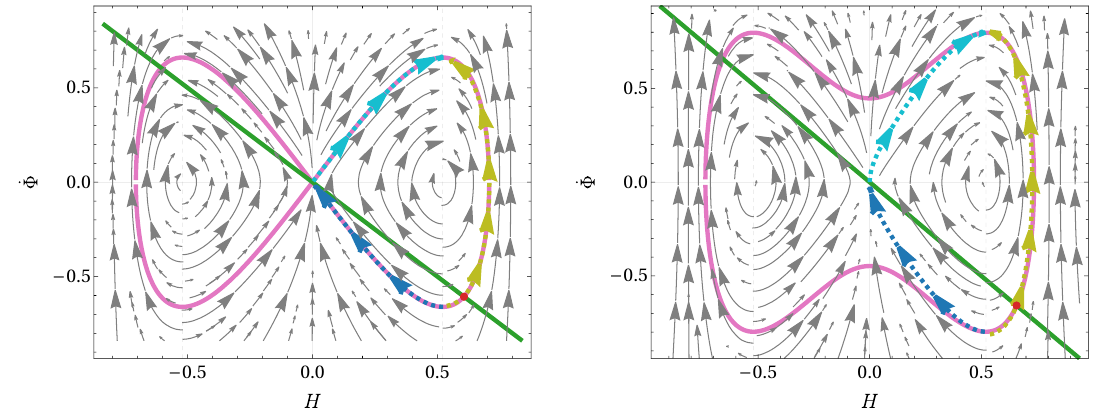
Figure 1 . Phase space diagram for the DBI ansatz (4.10) obtained from eqs. (4.11)–(4.12) for matter with w = λ = 0 . Units with α 0 = 1 are used, and the number of spatial dimensions is set to d = 3 . The pink curve depicts the constraint (2.25a) in vacuum ( ¯ ρ = 0 ; left plot) and for matter at the ‘initial’ time when κ 2 e Φ 0 ¯ ρ 0 = 10 − 1 (right plot). The dashed trajectories (in blue, cyan, and olive) show examples of consistent solutions. The green line shows the Einstein-frame bouncing condition ˙Φ + H = 0 , and the point where the condition is met on a physical trajectory is depicted by a red dot. See text for